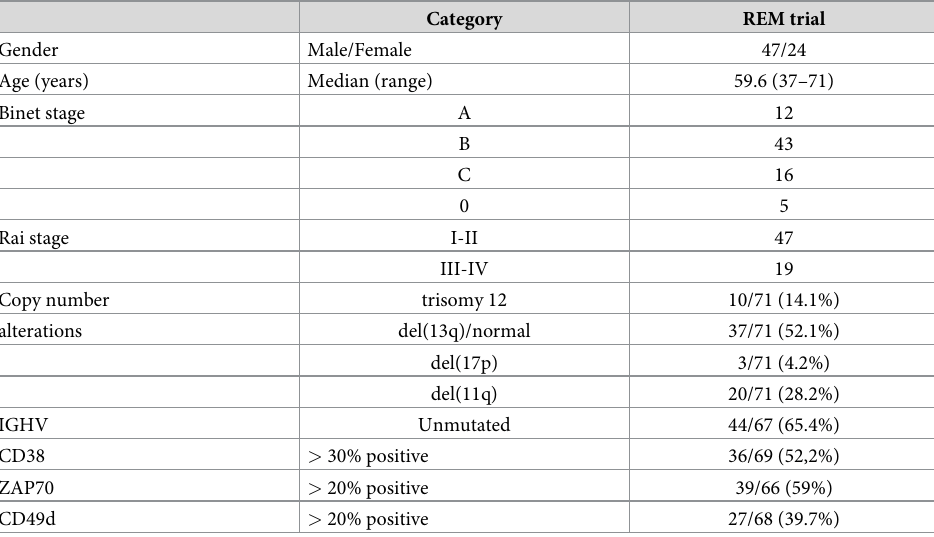
Table 1. Patients’